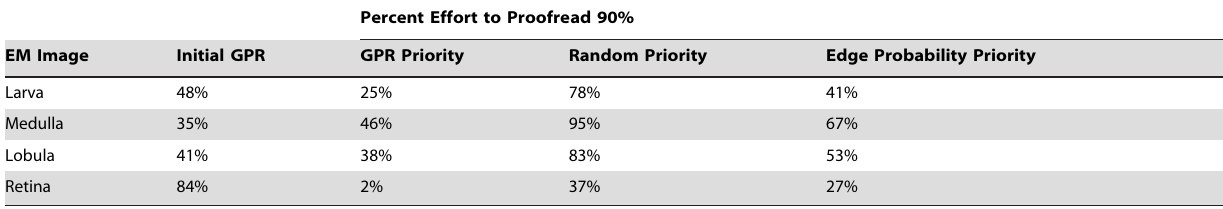
Table 1. Reducing reconstruction effort through